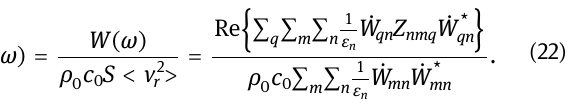
Table 3: The overall vibration level and the overall sound power